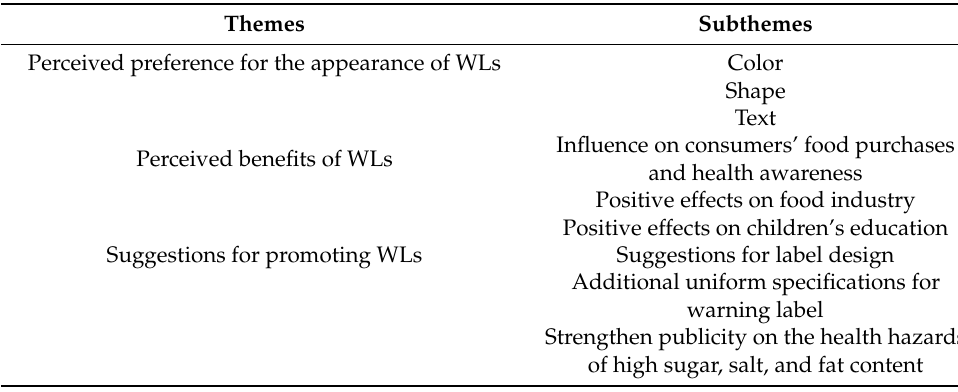
Table 1. Themes and